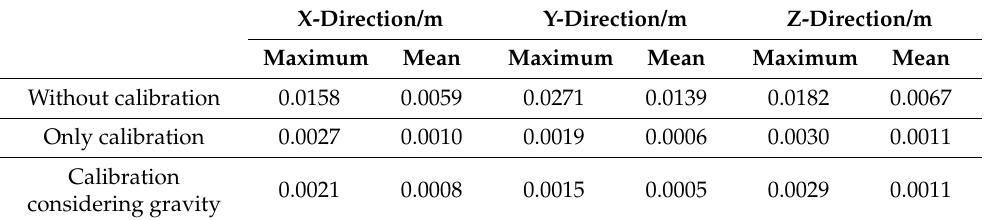
Figure 15. Verification of calibration considering gravity in X- ( a ) Y- ( b ), and Z- ( c ) directions. Table 5. Verification of calibration considering gravity in X-, Y-, and Z-directions.